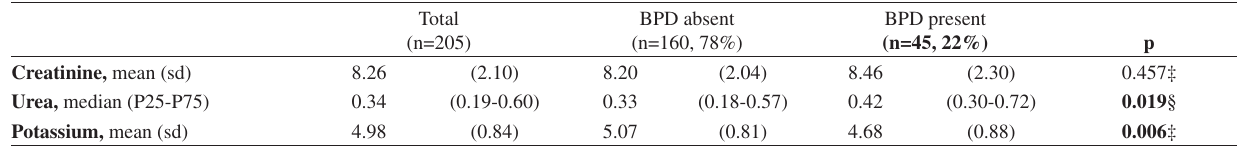
Table 7 - Comparison of renal function parameters on the seventh day of life between BPD and non-BPD patients.